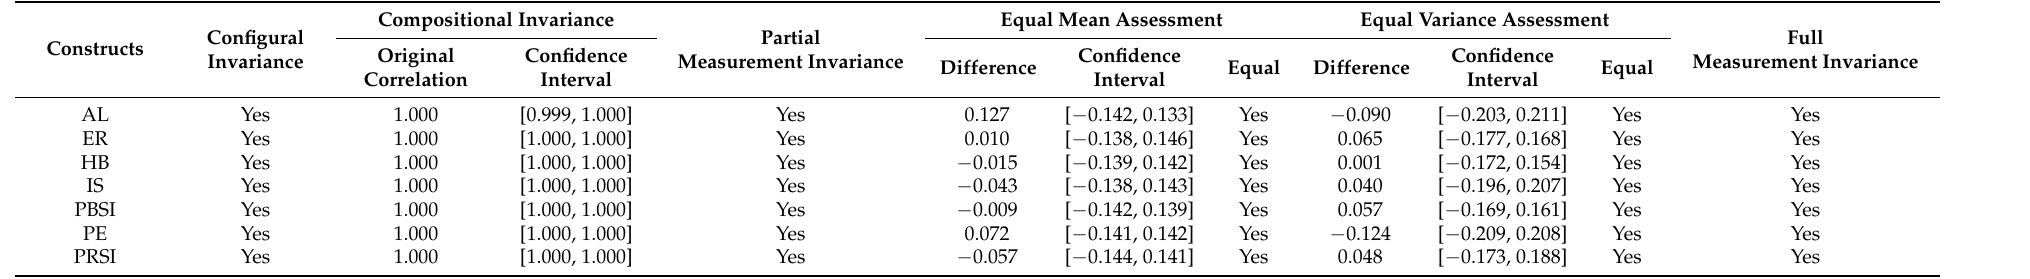
Table 6. Results of invariance measurement